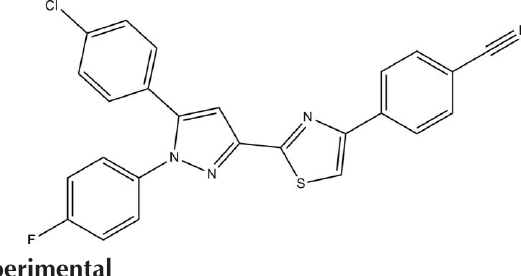
Data collection Bruker APEXII DUO CCD area- detector diffractometer Absorption correction: multi-scan ( SADABS ; Bruker, 2009)